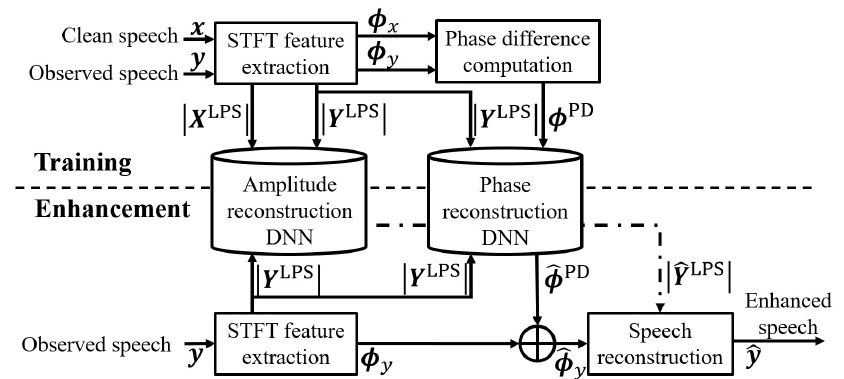
Figure 3. Block diagram of proposed STFT-based method.